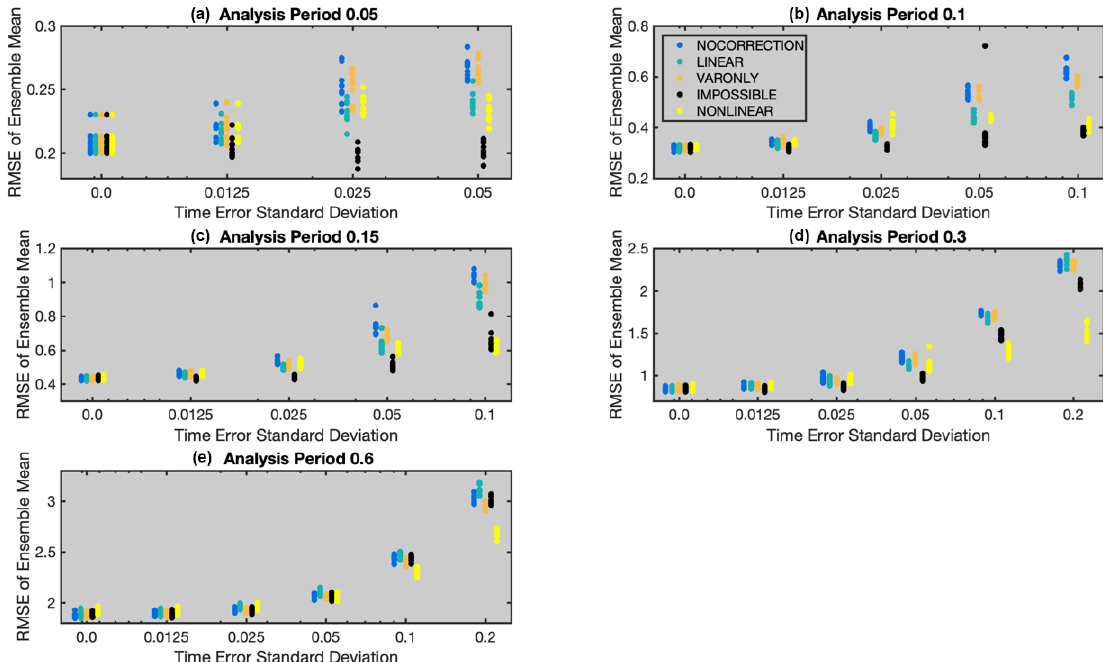
Figure 2. RMSE of the ensemble mean over 1000 analysis time steps for cases with an analysis period of (a) 0.05, (b) 0.1, (c) 0.15, (d) 0.3, or (e) 0.6 time units. Each dot in the graphs corresponds to an experiment run with a particular method, analysis period, and time error. A total of 10 experiments were run for each method–analysis period combination. The horizontal axis is logarithmic except for the 0 value.